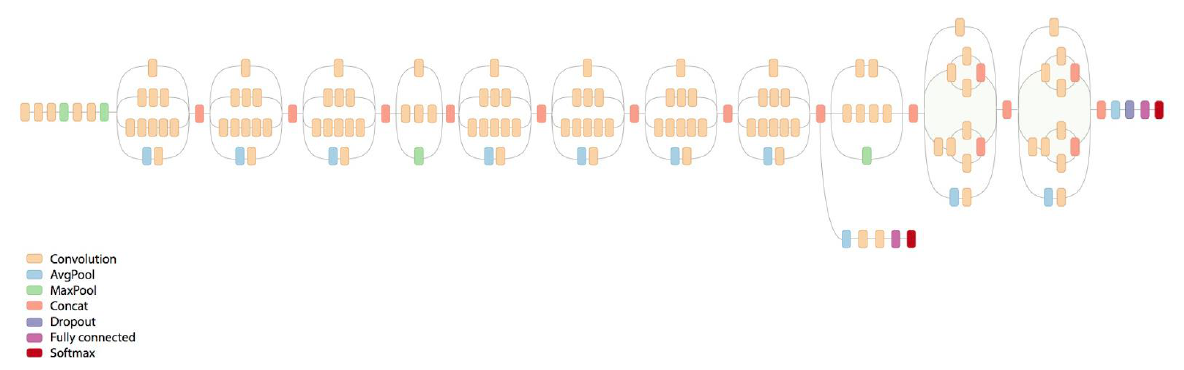
Figure 2. The architecture of the neural network "Inception v.3" (Szegedy et al. 2015; Shlens, 2016)